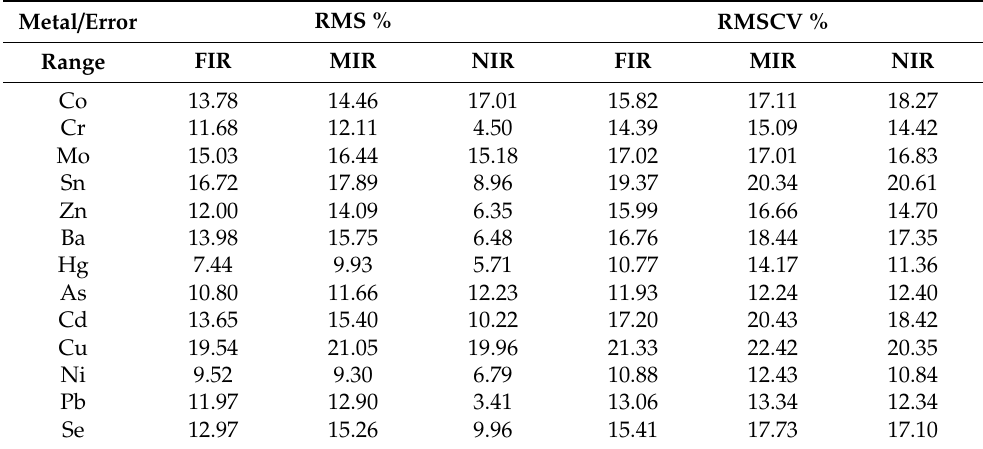
Table 4. Comparison of RMS and RMSCV values for PLS models based on each infrared range. (highest values of errors were marked with dark